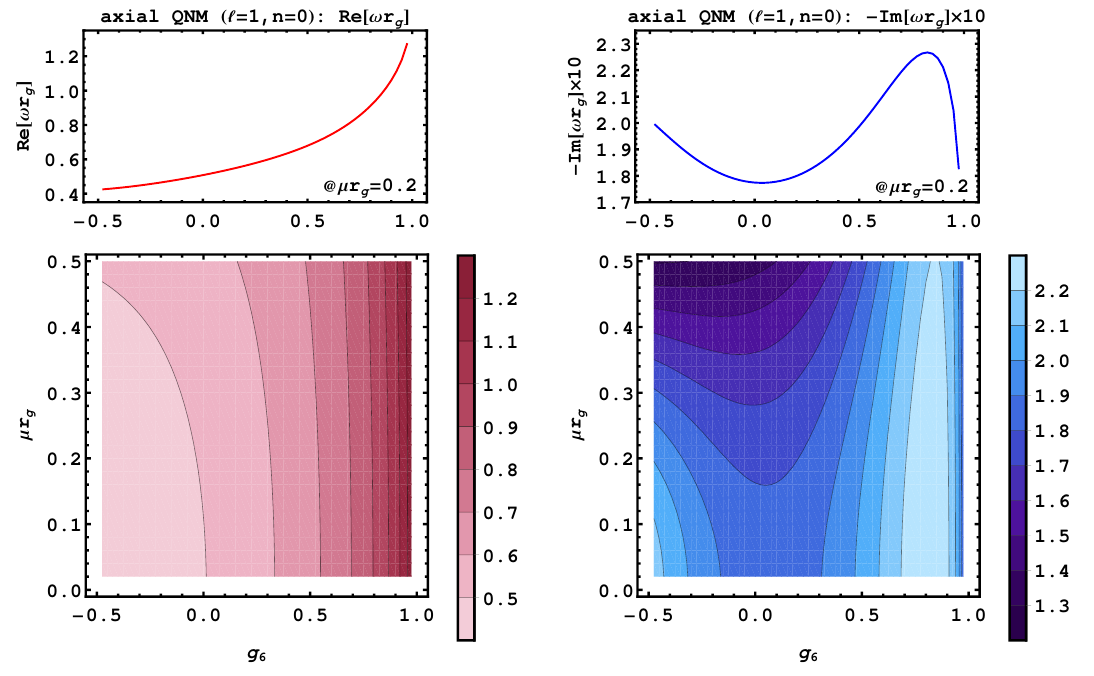
Figure 2 . Axial: real (left-hand panels) and imaginary (right-hand panels) part of the fundamental ( n = 0 ) first multipole ( ‘ = 1 ) QNM in the g 6 – µ plane (lower panels) and as a function of g 6 at µ r g = 0 . 2